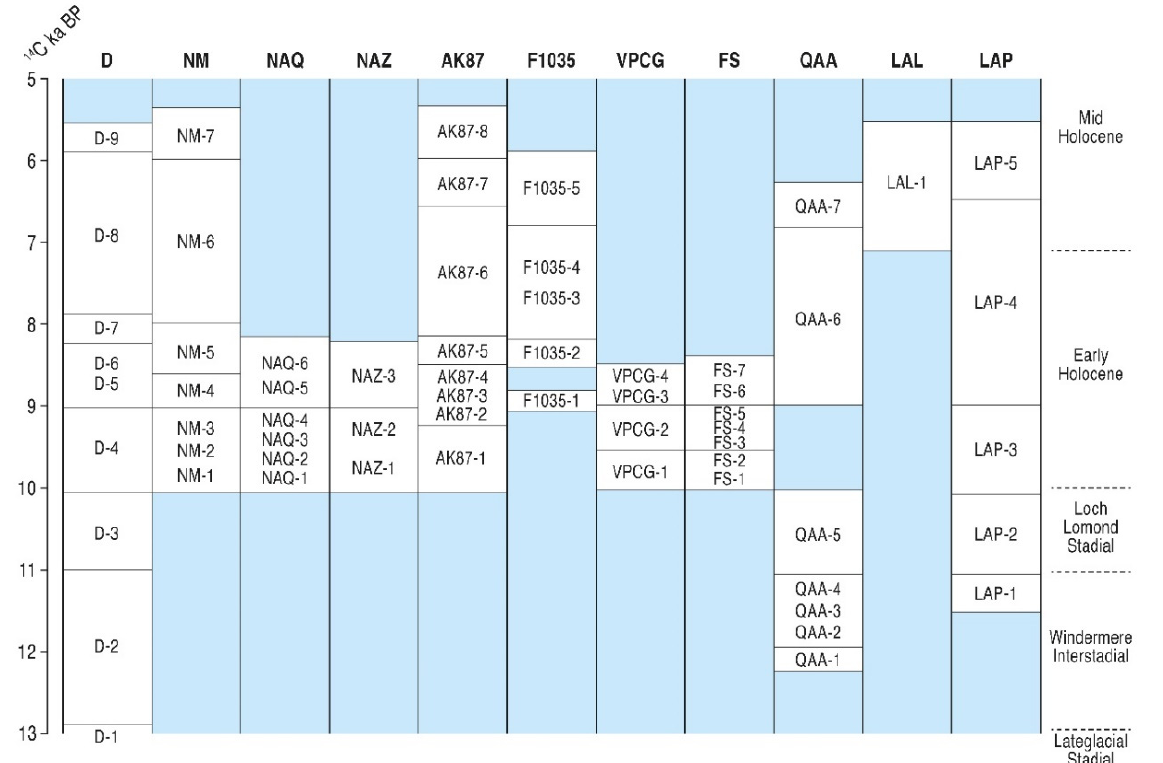
Figure 13. Correlation of pollen assemblage zones from the eleven new profiles at Lake Flixton. Blue shading denotes areas which could not be sampled for pollen because of the core ending, oxidation of upper sections or intrusive sand layers.